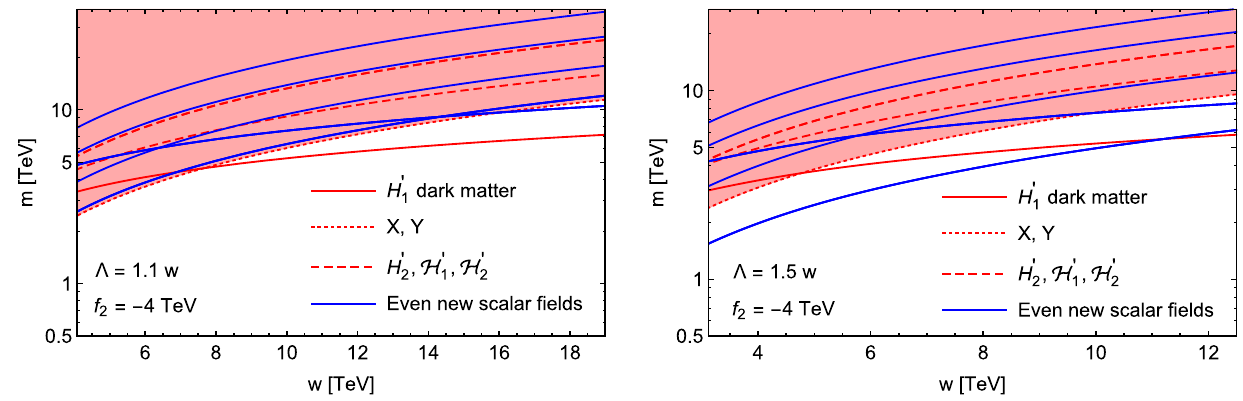
Fig. 5 The relic density of the scalar candidate as a function of the DM mass, which all vary according to the variation of w and (cid:11) , but with several relations as fixed, where the DM unstable region (light red) is the band on the left side of each panel